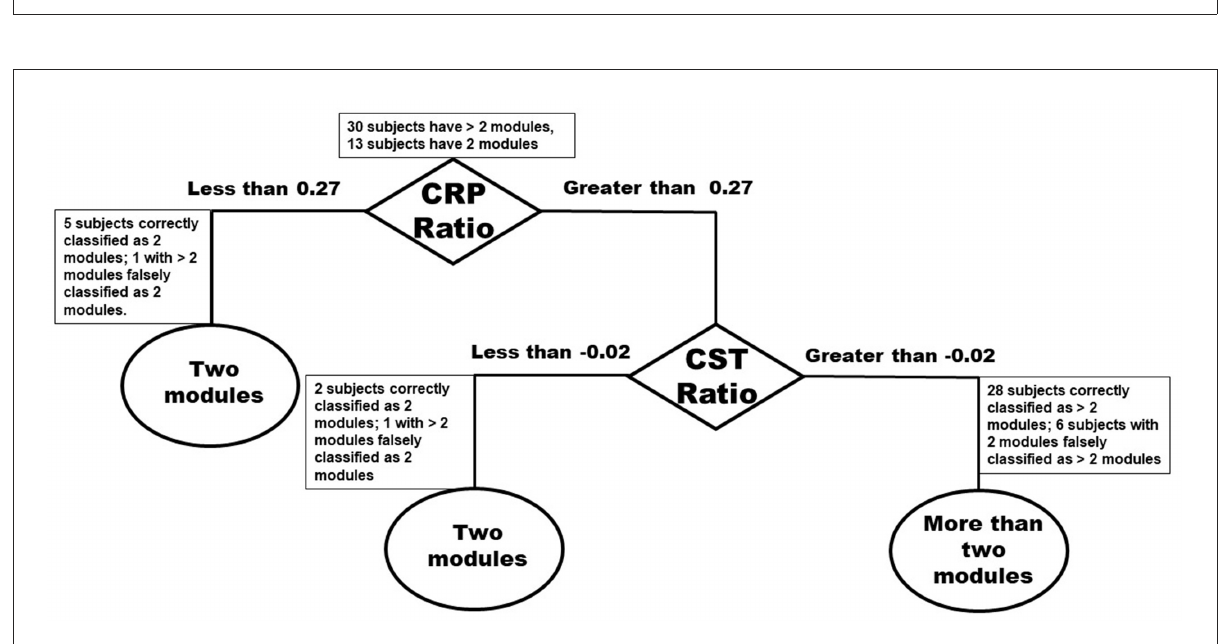
FIGURE6 Classification tree based on number of modules and Inter-hemispheric asymmetry of CST and CRP streamlines.